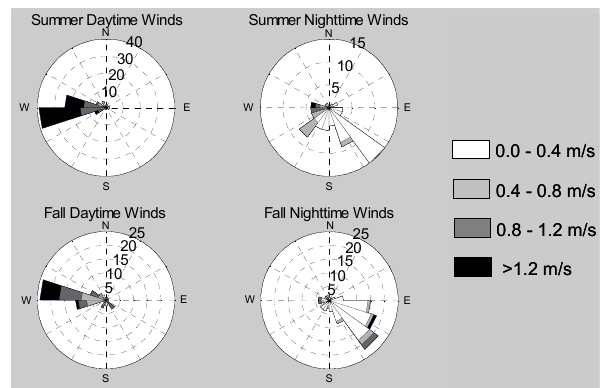
Fig. 2. Hourly average daytime and nighttime winds, measured at TAG inlet height (i.e., 7m), for SOAR focus periods, separated by summer (29 July–8 August) and fall (4 November–14 November) 2005. Concentric rings represent frequency of